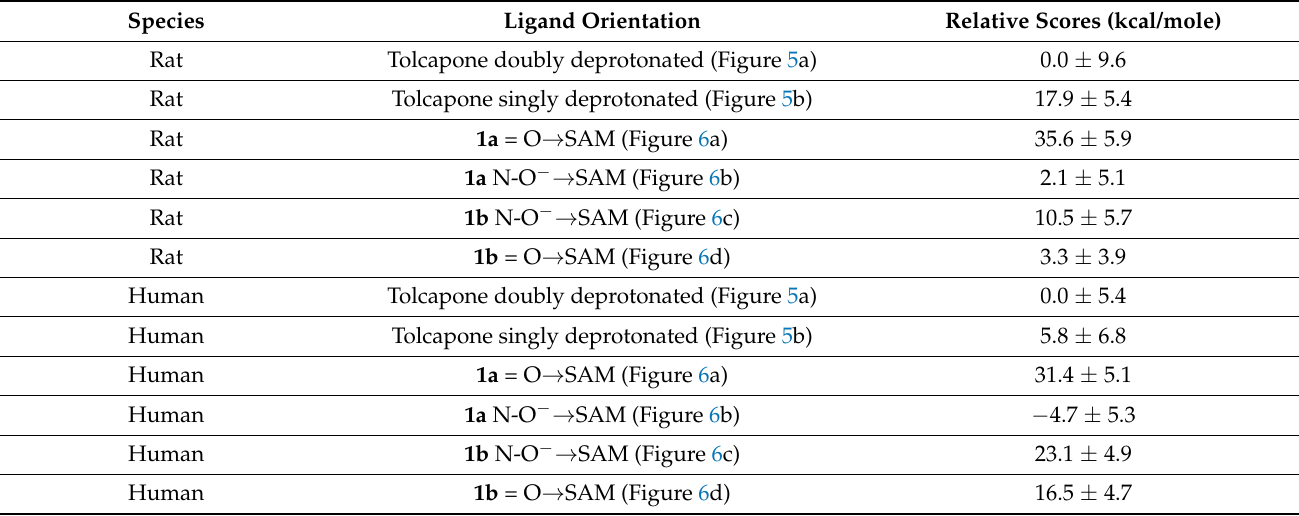
Table 5. Relative Binding Free Energy Scores.